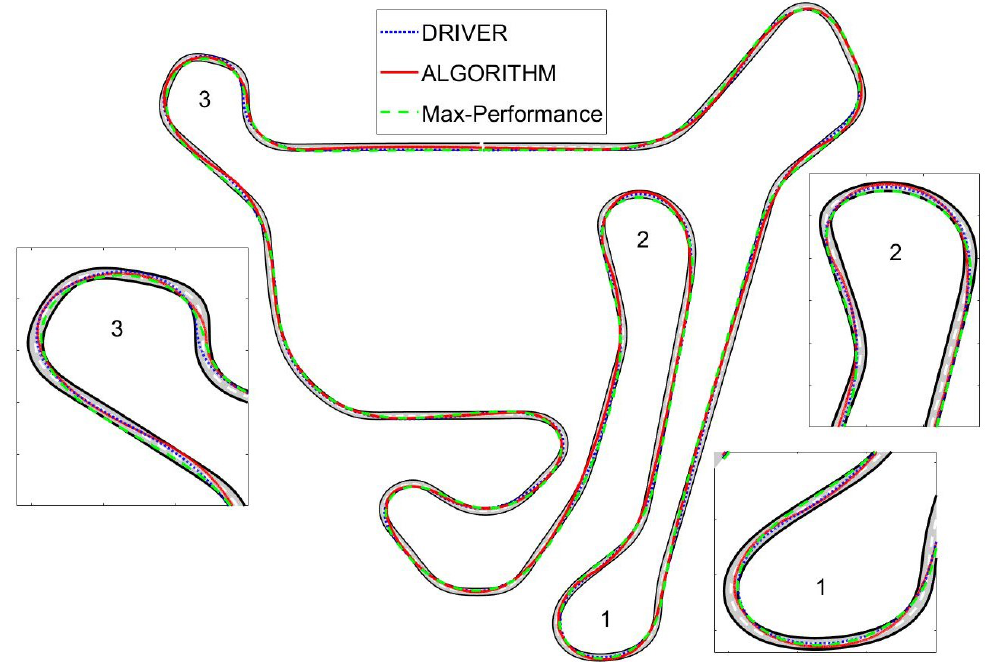
Figure 11. Comparison of the trajectory made by the algorithm proposed and the